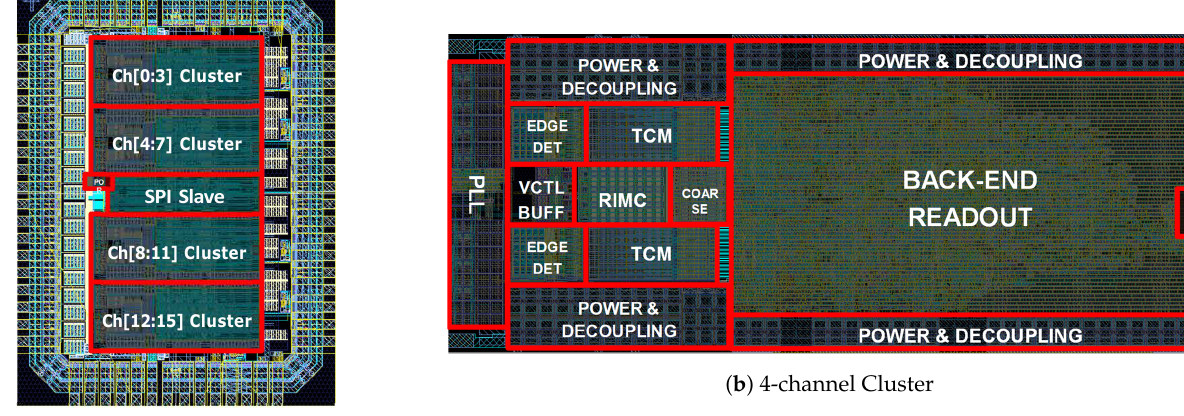
Figure 2. Detailed floor plan of the ASIC, including all the building blocks of one cluster of 4